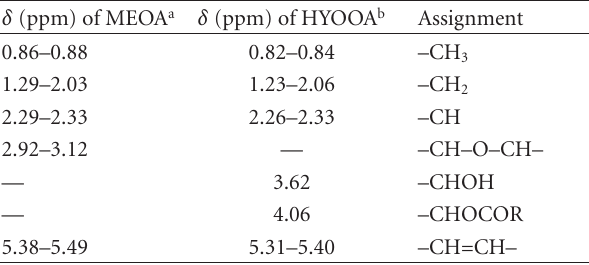
Table 7: The main signals present in 1 H NMR functional groups